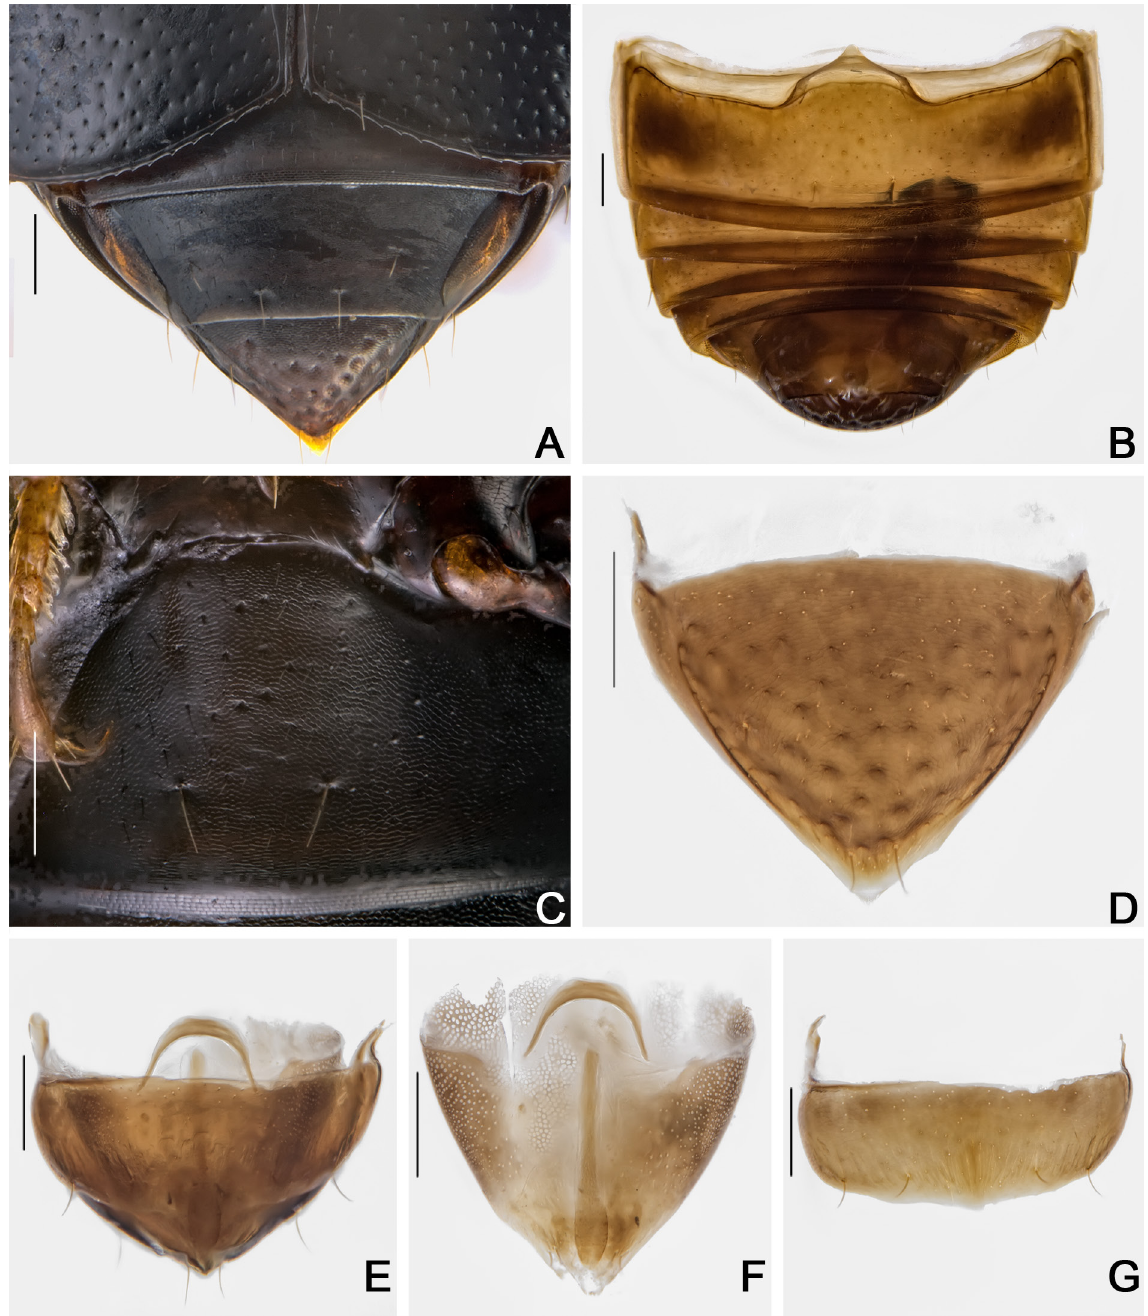
Fig. 52. Cyparium collare Pic, 1920, ♂♂ (CELC). A–B . Abdomen. A . Dorsal view. B . Ventral view. C . Ventrite 1. D . Tergite VIII. E . Terminalia. F . Tergite IX. G . Sternite VIII. Specimens collected at Mata do Paraíso, Viçosa (MG, Brazil). Scale bars = 0.2